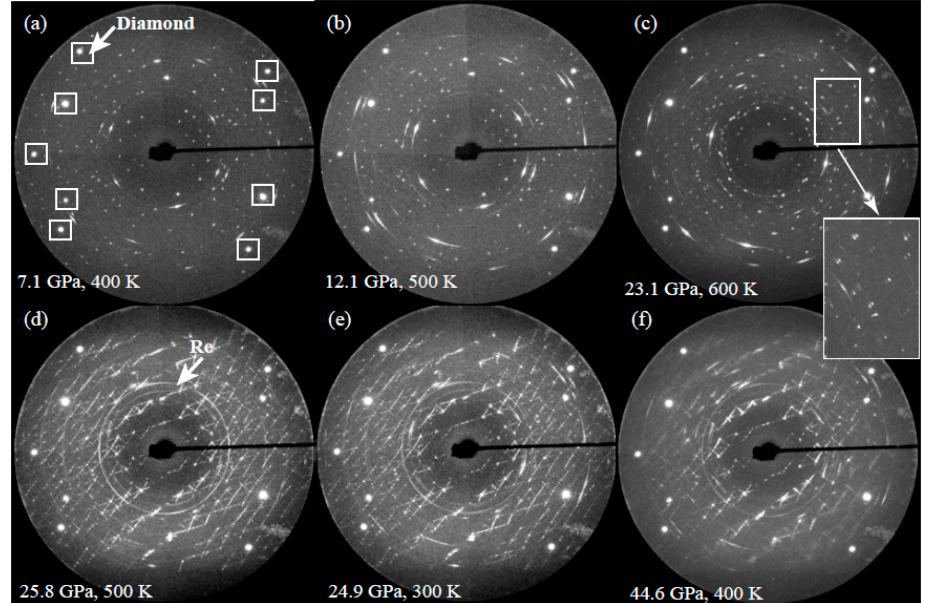
Figure 2. Representative two-dimensional XRD patterns of vanadinite collected at high pressures and temperatures. ( a ) XRD pattern at 7.1 GPa and 400 K. ( b ) XRD pattern at 12.1 GPa and 500 K. ( c ) XRD pattern at 23.1 GPa and 600 K. ( d ) More complex XRD pattern at 25.8 GPa and 500 K. ( e ) Complex XRD pattern at 24.9 GPa and 300 K. ( f ) XRD pattern at 44.6 GPa and 400 K. Large white spots in the white squares are due to diamond reflections. The diffraction rings are due to gasket (Re) reflections. The inset illustrates the splittings of Bragg’s peaks.